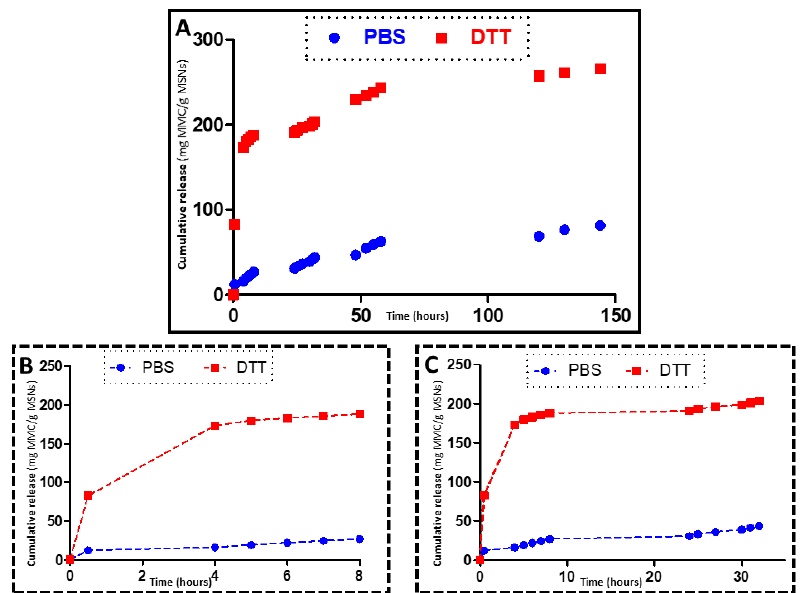
Figure 6. Kinetics of MMC release by DTT; MSNPs-PEG 40 loaded with MLP were incubated with DTT (activation, red) or PBS (control, blue) at 37 °C, and samples were taken at different periods of time ( A ). Representative curves after 8 h of release experiment ( B ) and after 32 h of release experiments ( C ).